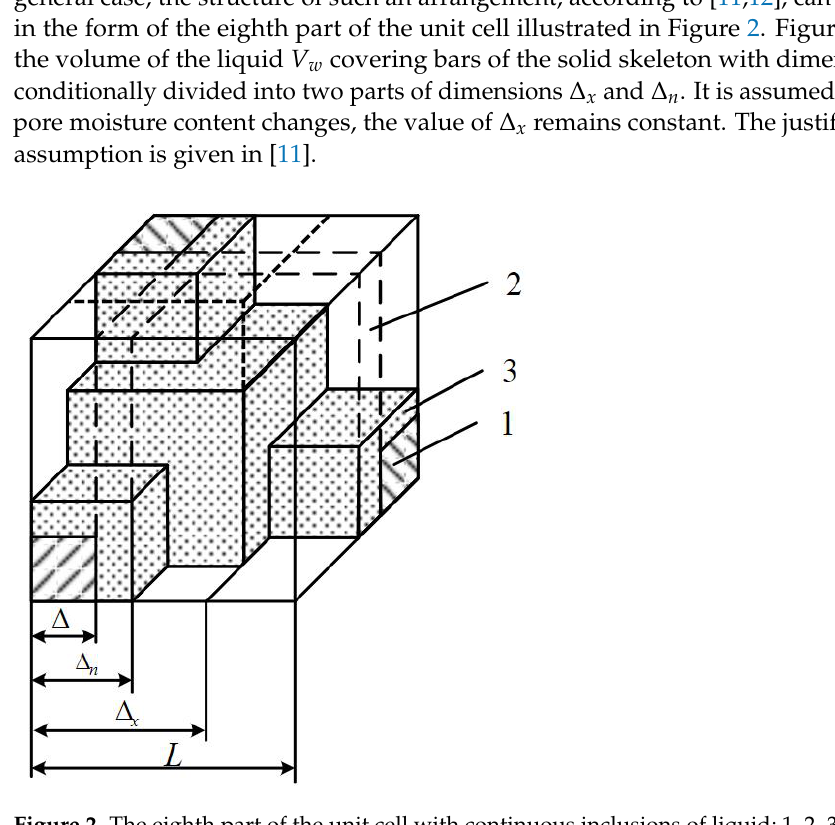
Figure 2. The eighth part of the unit cell with continuous inclusions of liquid; 1, 2, 3—solid, gas and liquid components,